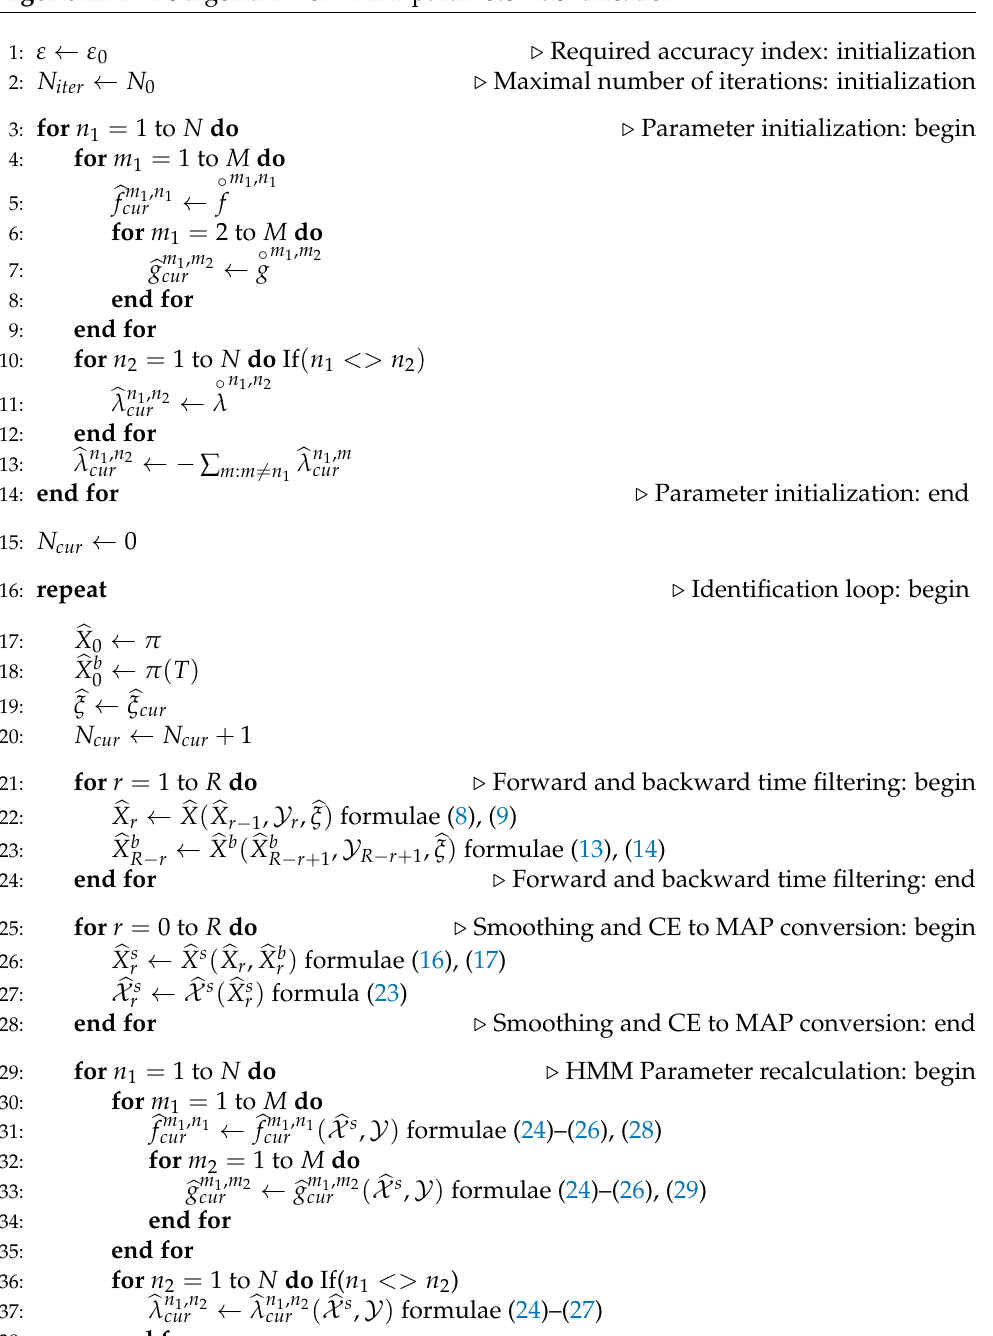
Algorithm 1 The algorithm for HMM parameter